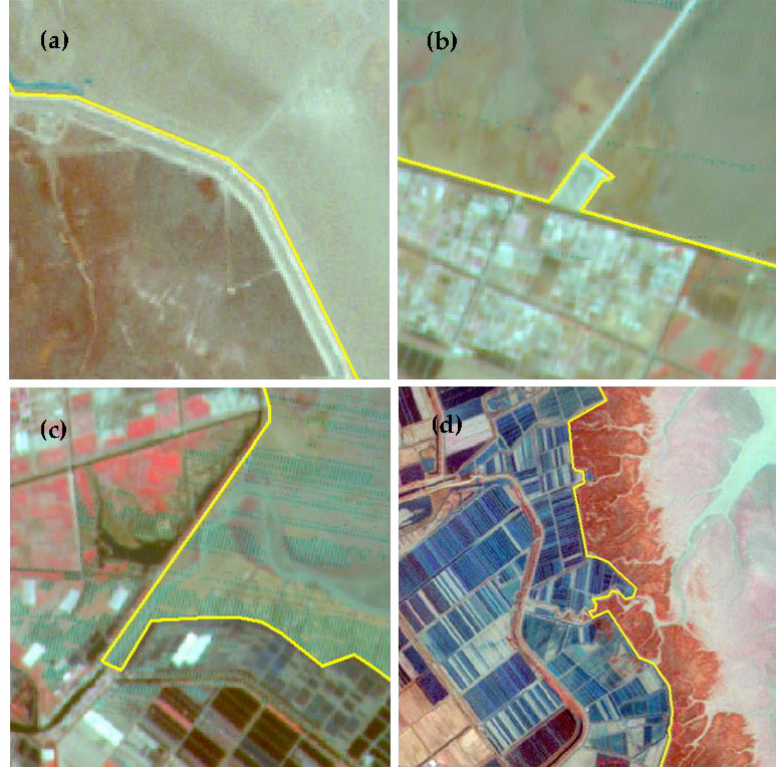
Figure 2. Remote sensing images of artificial shorelines. ( a ) Dike or breakwater in MSS (654) image; ( b ) dock in TM (432) image; ( c ) estuary in HJ−1(432) image; ( d ) breeding ponds in OLI (543) image.